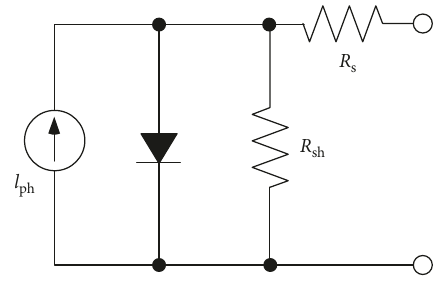
Figure 7: Schematic of equivalent circuit of solar cell.